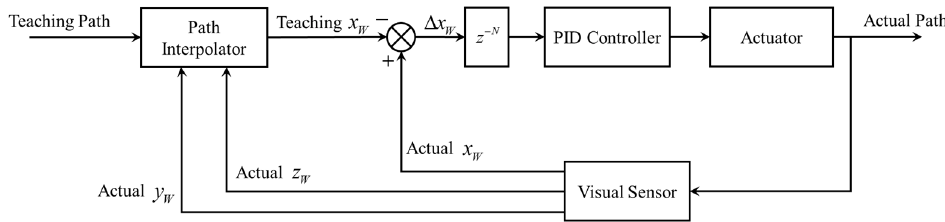
Figure 28. The motion control system during the welding process.